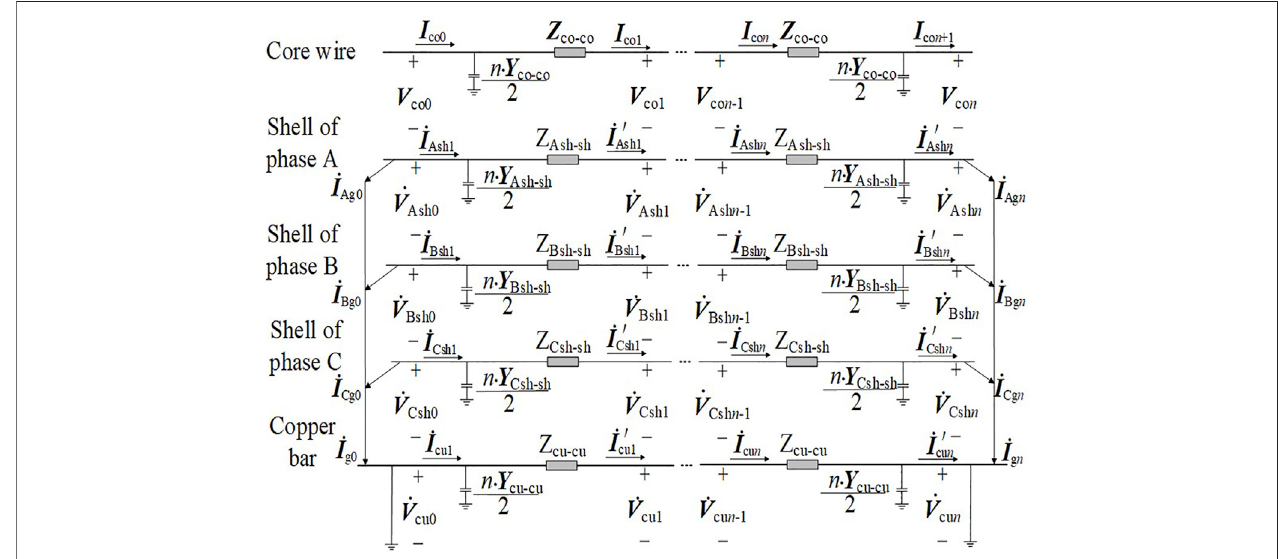
FIGURE 3 | GIL equivalent circuit of the fi rst and last sections.